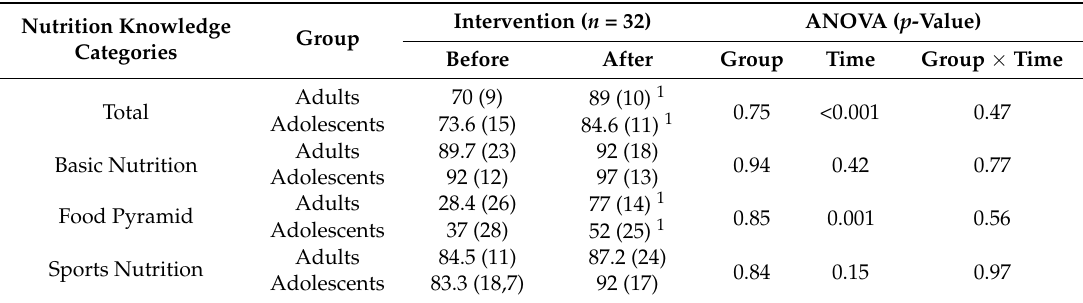
Table 4. Mean (SE) of athlete’s nutritional knowledge before and after the